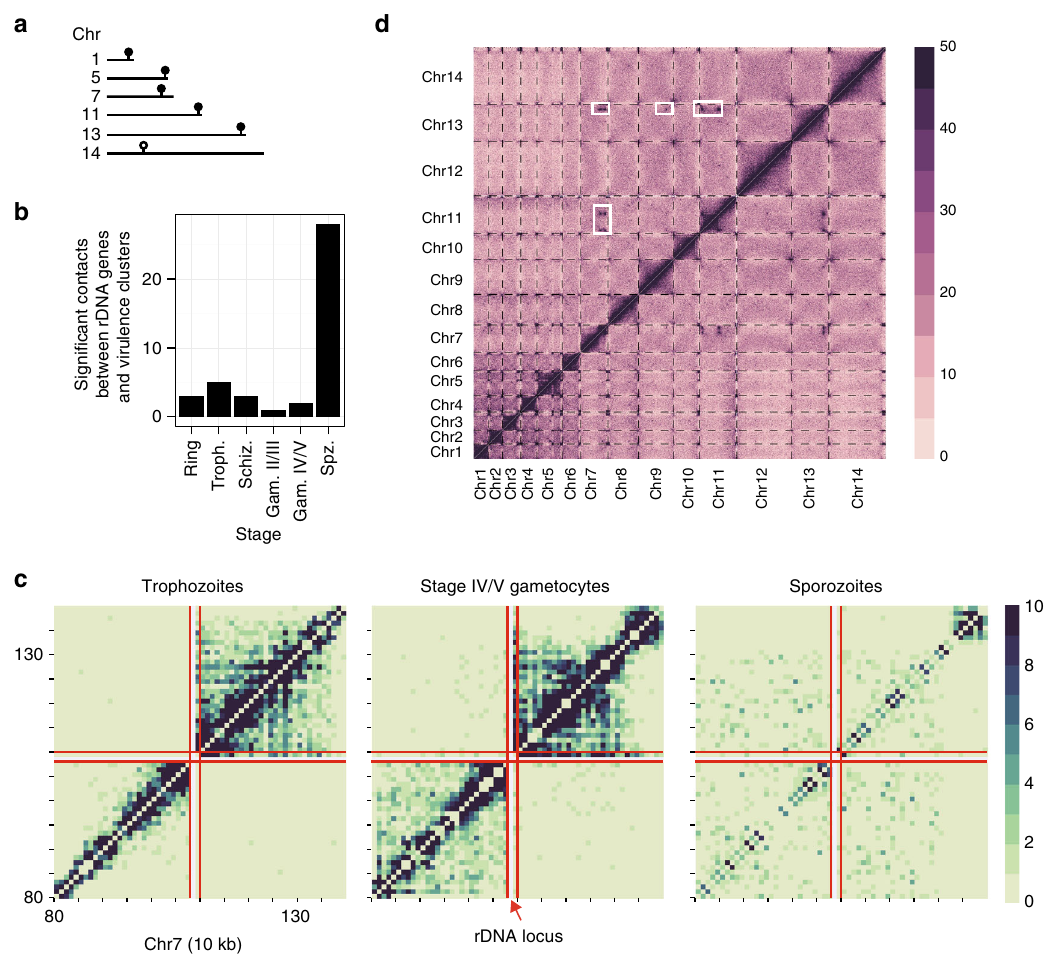
Fig. 5 Changes in genome organization in salivary gland sporozoites. a Locations of rDNA genes in the P. falciparum genome. Units of 28S, 5.8S, and 18S genes on chromosomes 1, 5, 7, 11, and 13 are indicated with a fi lled symbol. Several additional rDNA genes are located on other chromosomes, including a unit of three 5S genes on chromosome 14, which is indicated with an open symbol. b Increased overall number of interactions between rDNA genes and virulence genes in P. falciparum sporozoites. c Loss of domain formation around the rDNA locus on chr7 in P. falciparum sporozoites as compared to other life cycle stages. The borders of the rDNA locus are indicated by red lines. d Strong interchromosomal interactions in P. vivax sporozoites, indicated by white rectangles. Dashed lines indicate chromosome